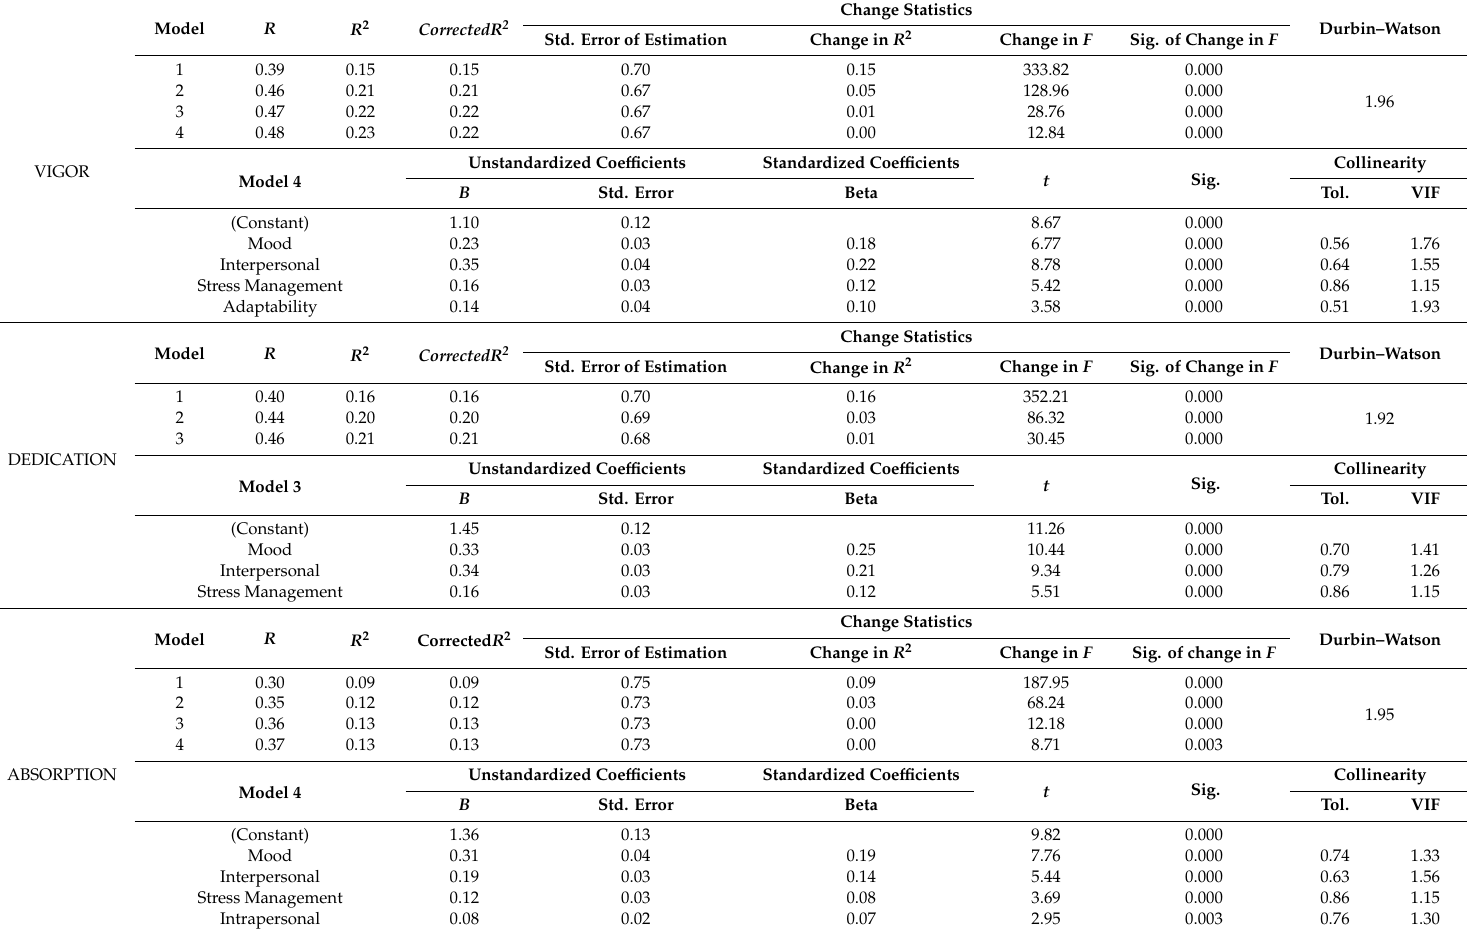
Table 2. Stepwise multiple linear regression model. Vigor, dedication, absorption (women; n =